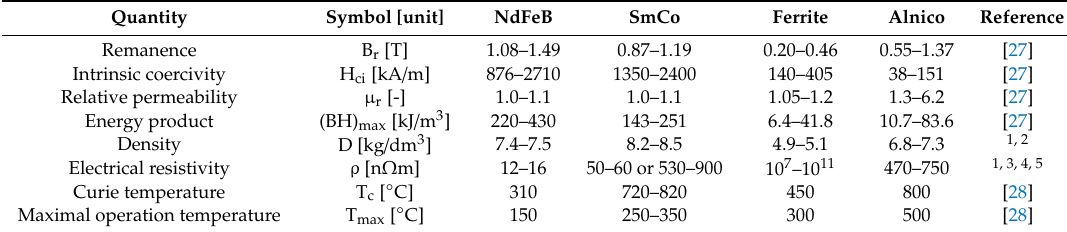
Table 1. Some properties of permanent magnets (PMs) relevant to electrical